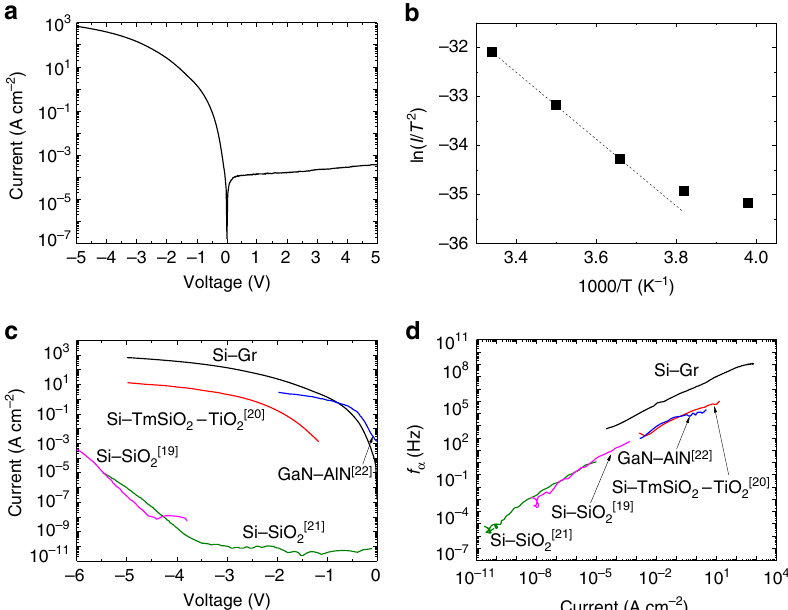
Fig. 2 Schottky emitter of the Si – Gr-Ge transistor. a A typical I – V characteristic of the top Si – Gr emitter junction at room temperature showing an obvious rectifying behavior. b Temperature-dependent characteristics of the current. An Arrhenius plot at a voltage of − 0.1 V gives a Schottky barrier height of 0.64 eV at room temperature. c Comparison of the on-currents of graphene-base transistors with different emitters. The Si – Gr Schottky emitter shows a current of 692 A cm − 2 at − 5 V. d Comparison of f α of graphene-base transistors with different emitters. The one with the Si – Gr Schottky emitter shows the best cutoff frequency of 1.2